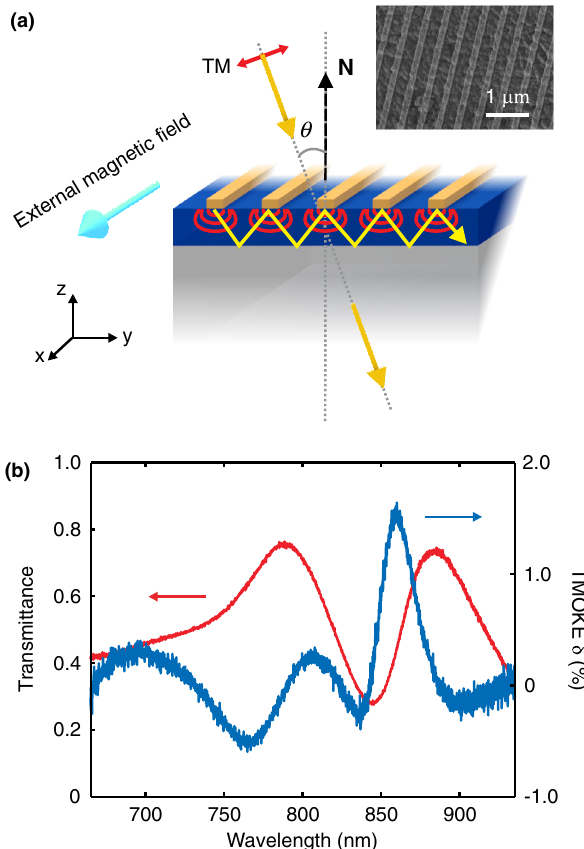
FIG. 1. (a) Schematic of the plasmonic system employed to enhance the transverse magneto-optical Kerr effect. The bismuth iron garnet film (blue) is deposited on glass substrate (grey), and the gold nanowires are structured on top. An external magnetic field B is applied in plane. Obliquely incident light (incident angle (cid:2) ) is polarized perpendicular to the nanowires (TM polar- ization). Inside the bismuth iron garnet film, the red lines close to the nanowires illustrate the near-field enhancement due to the plasmonic resonance, and the yellow lines illustrate light bounc- ing up and down inside the waveguide due to the waveguide mode in a simplified geometrical optics analogy. N is the surface normal of the substrate. The inset shows a scanning electron micrograph of a sample. (b) Measured spectrum of transmittance at a zero B field (red line) and the measured spectrum of the TMOKE signal (cid:1) at (cid:3) 160 mT (blue line), with a 9 (cid:2) incident angle for the sample with a 500-nm